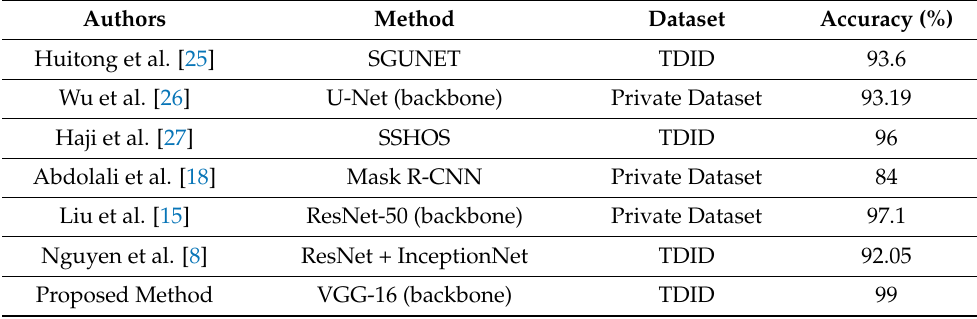
Table 5. Comparison of the proposed method with other existing